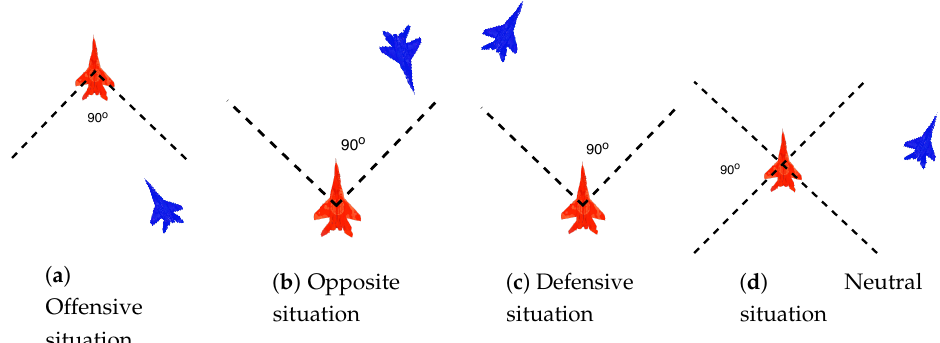
Figure 5. The four different initial situation of the WVR aerial combat